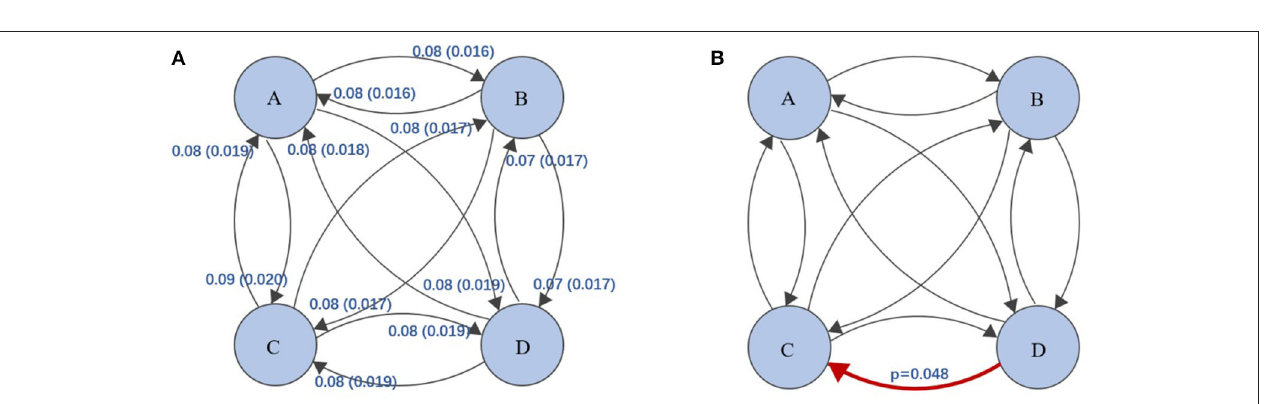
and disgust sensitivity score [ F (1,192) = 4.0493, p = 0.0456, 1 R